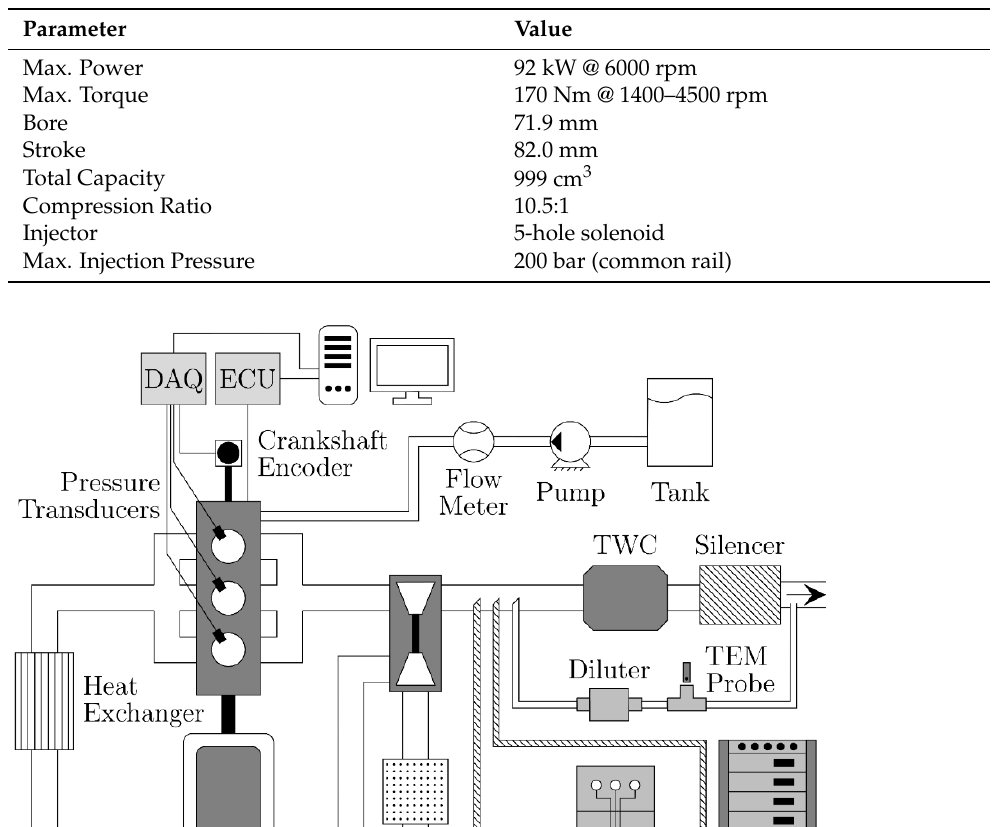
Table 1. Specifications of the three-cylinder GDI engine.